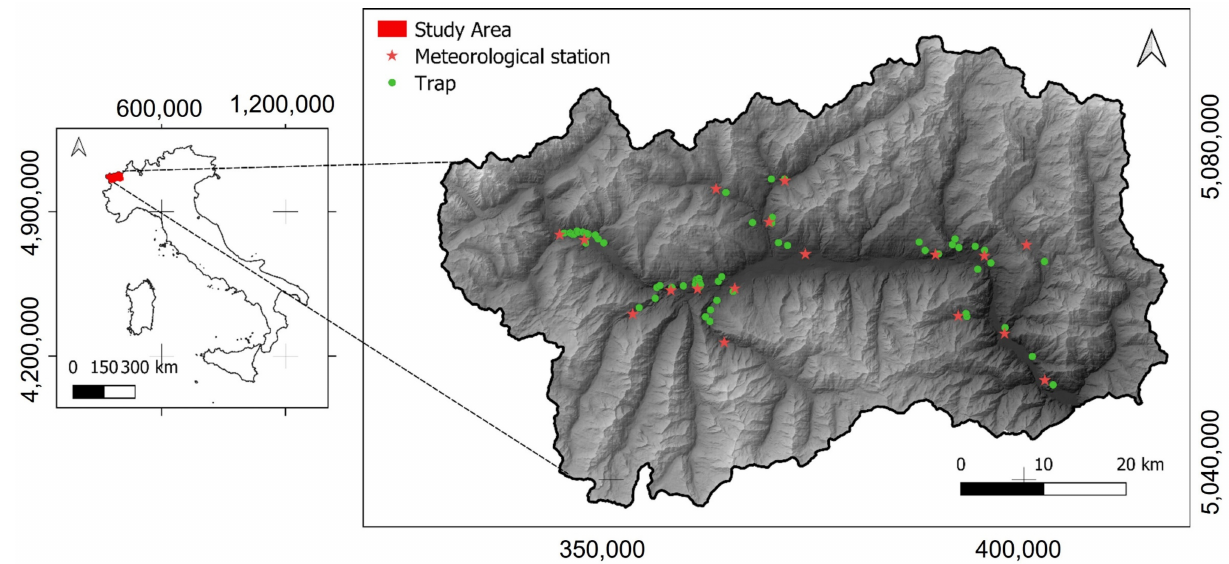
Figure 1. Distribution of traps (green) and meteorological stations (red) in Aosta Valley region. The maximum distance of traps from meteorological stations is 3.5 km in length and ± 250 m in elevation. Reference system is WGS84/UTM 32N, EPSG: